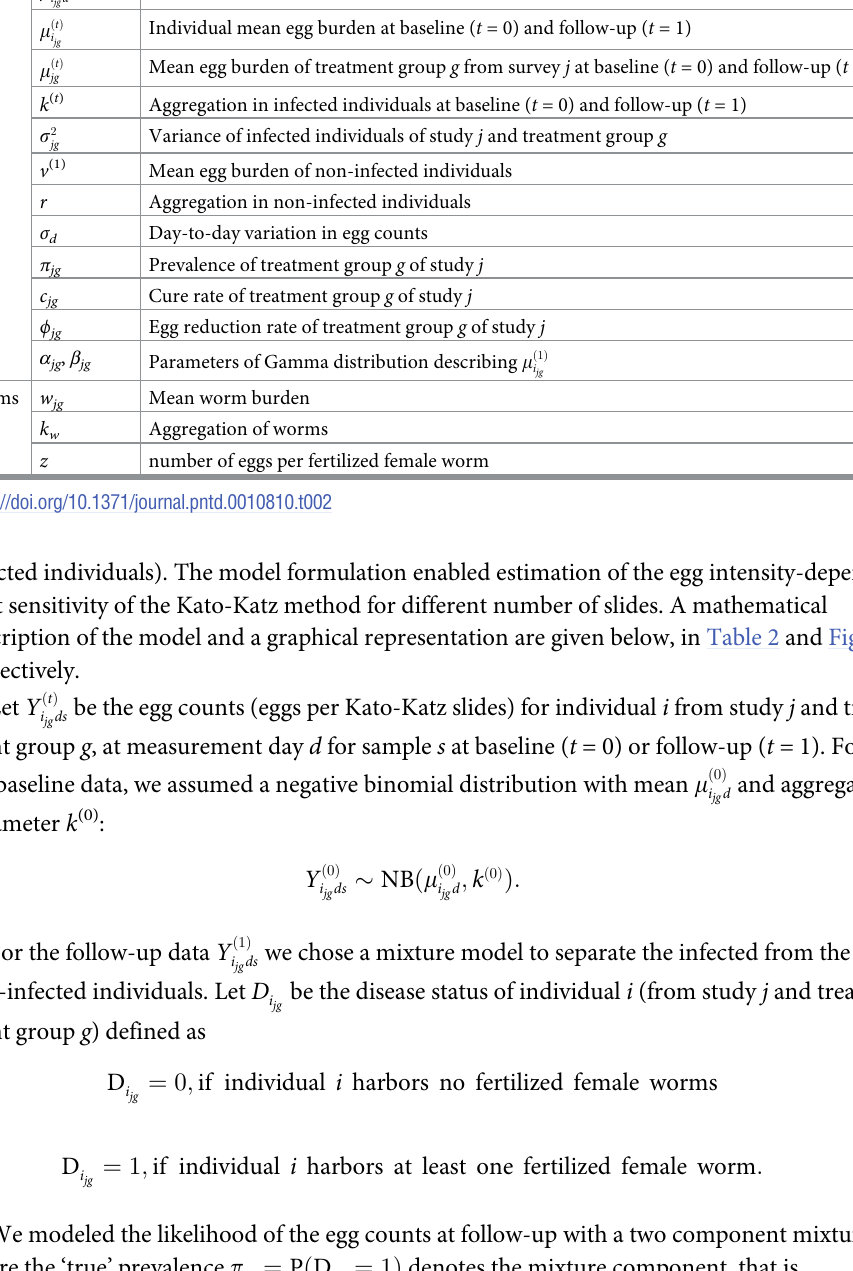
Table 2. Description of parameters used in the model. Parameter Description Daily individual mean egg burden at baseline ( t = 0) and follow-up ( t = 1) Eggs m ð t Þ i jg d Individual mean egg burden at baseline ( t = 0) and follow-up ( t = 1) m ð t Þ i jg Mean egg burden of treatment group g from survey j at baseline ( t = 0) and follow-up ( t = 1) m ð t Þ jg k ( t ) Aggregation in infected individuals at baseline ( t = 0) and follow-up ( t = 1) Variance of infected individuals of study j and treatment group g s 2 jg v (1) Mean egg burden of non-infected individuals r Aggregation in non-infected individuals σ d Day-to-day variation in egg counts π jg Prevalence of treatment group g of study j c jg Cure rate of treatment group g of study j ϕ jg Egg reduction rate of treatment group g of study j α jg , β jg Parameters of Gamma distribution describing m ð 1 Þ Worms w jg Mean worm burden k w z number of eggs per fertilized female